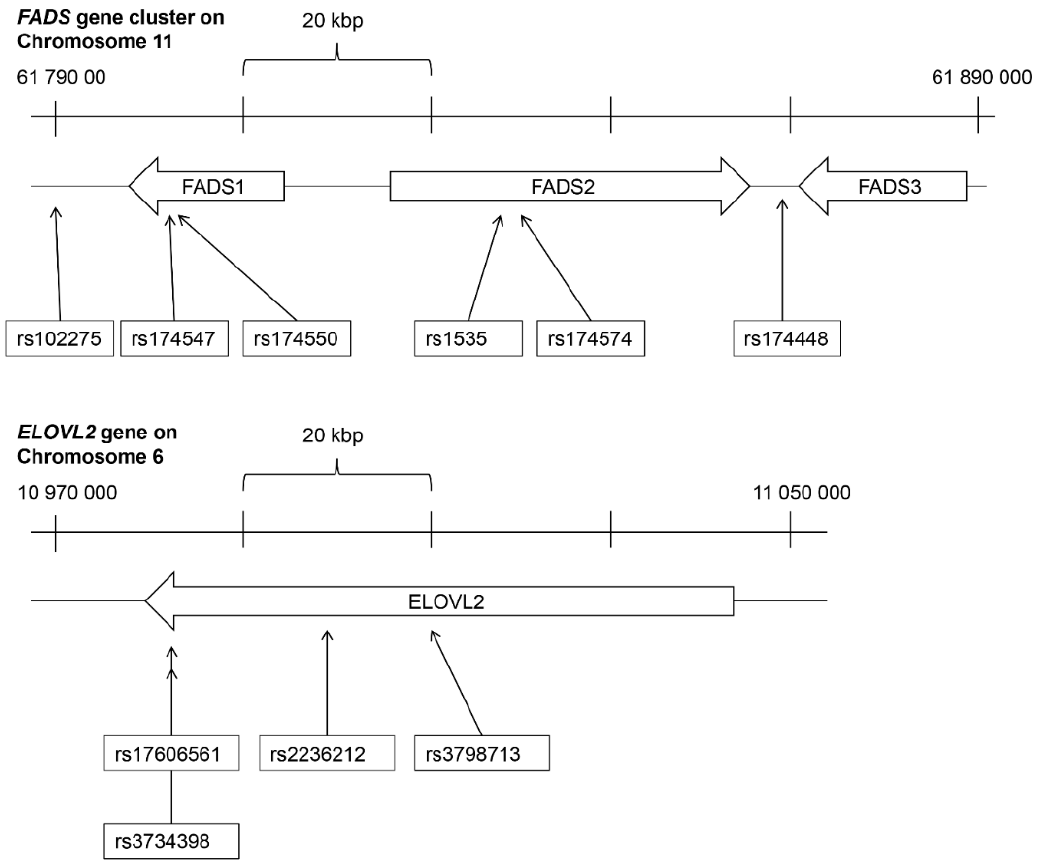
Figure 2. Overview of the FADS gene cluster (in top) and the ELOVL2 gene (below) and the SNPs analyzed in this study. Position was derived from UCSC Genome Browser on Human December 2013 (GRCh38/hg38) Assembly .